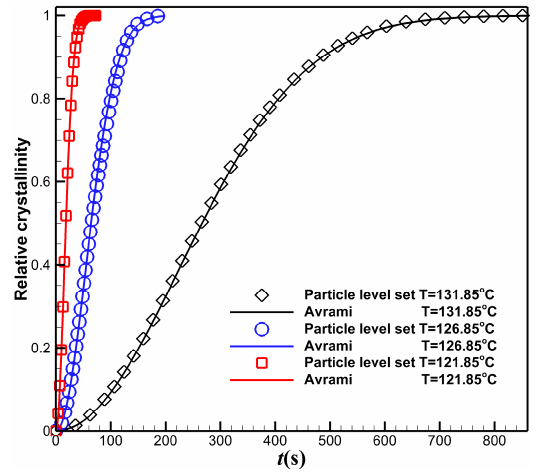
Figure 9. Relative crystallinity evolution under different temperatures in isothermal condition.